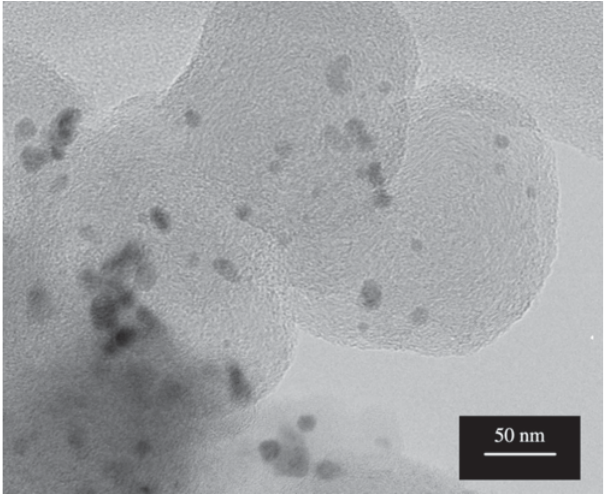
Figure 4. Nanocrystals of PtRu (B2) electrocatalyst, well dispersed in the carbon matrix, but with an average crystallite size of 9.9 ± 2.5